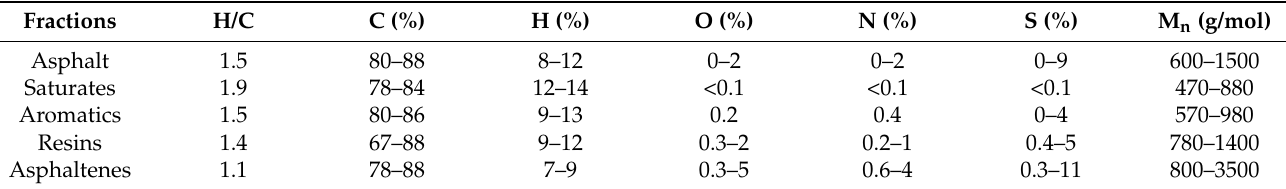
Table 2. Chemical properties of asphalt and four fractions [34].